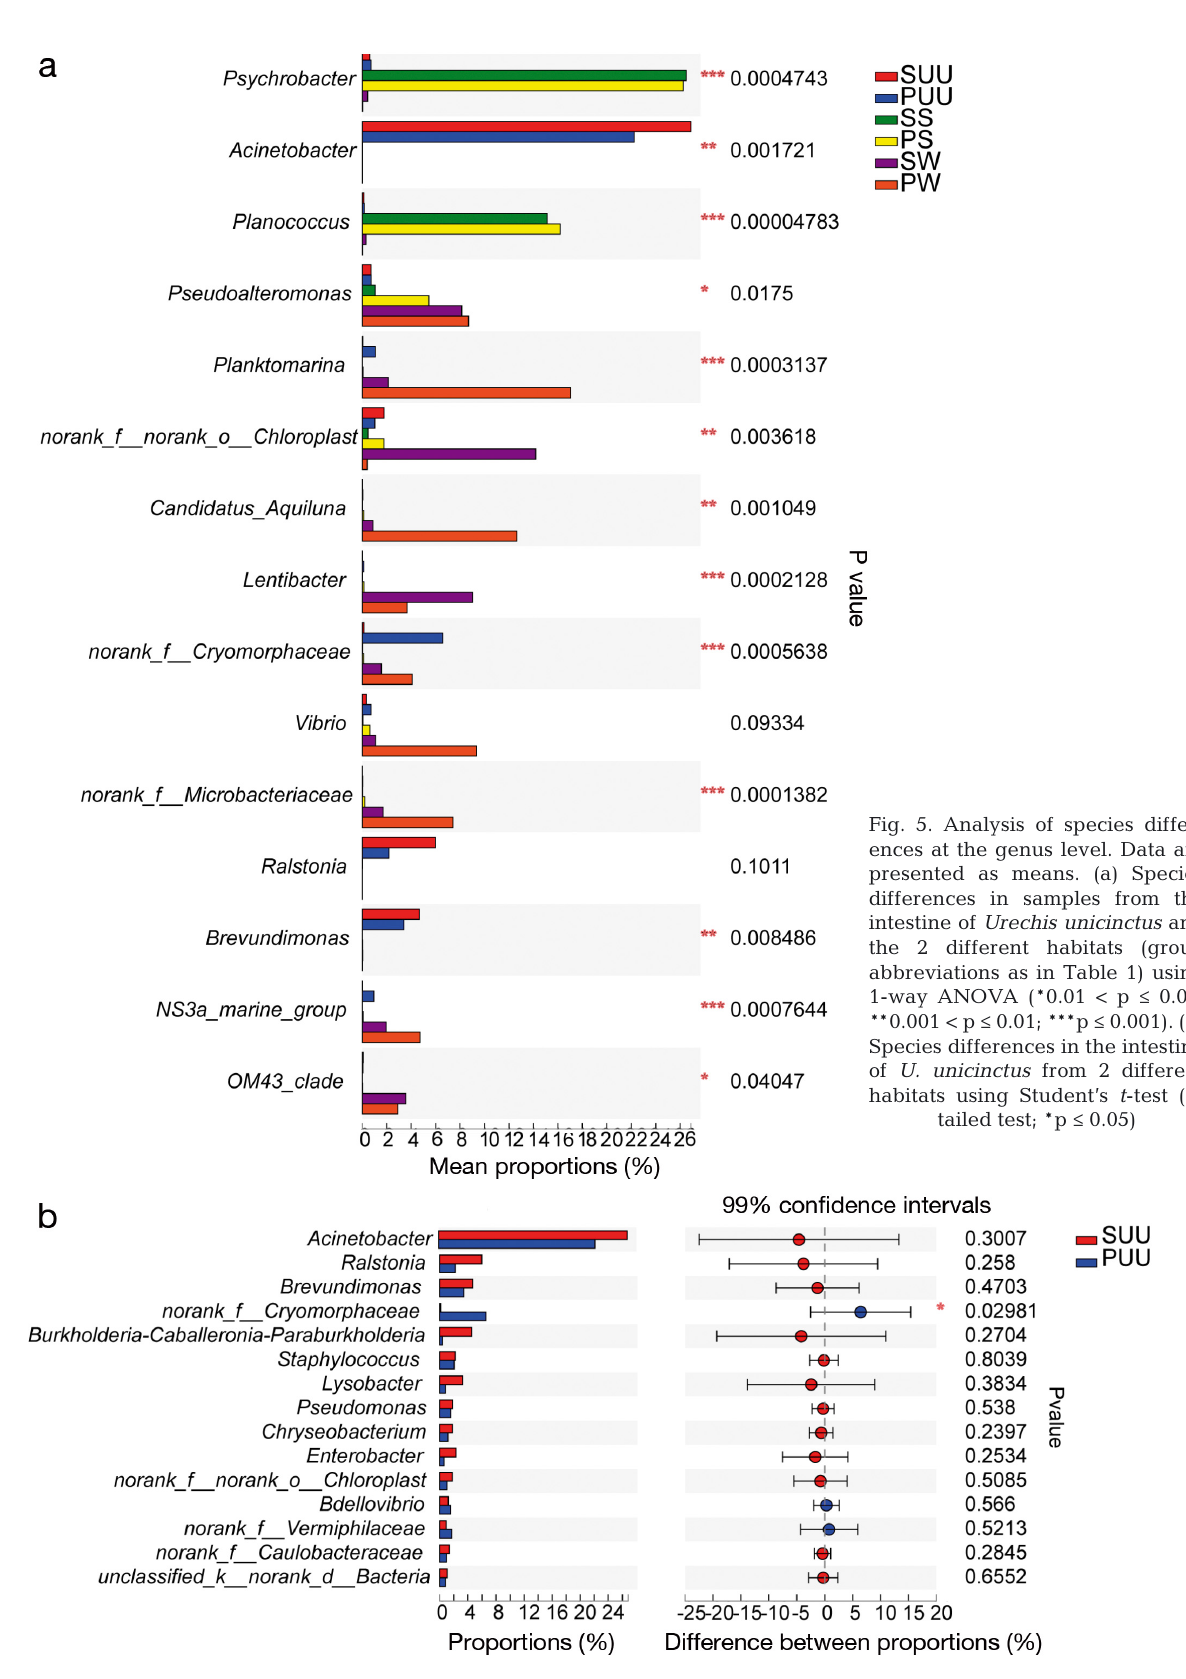
Fig. 5. Analysis of species differ- ences at the genus level. Data are presented as means. (a) Species differences in samples from the intestine of Urechis unicinctus and the 2 different habitats (group abbreviations as in Table 1) using 1-way ANOVA (*0.01 < p ≤ 0.05; **0.001 < p ≤ 0.01; ***p ≤ 0.001). (b) Species differences in the intestine of U. unicinctus from 2 different habitats using Student’s t -test (2- tailed test; *p ≤